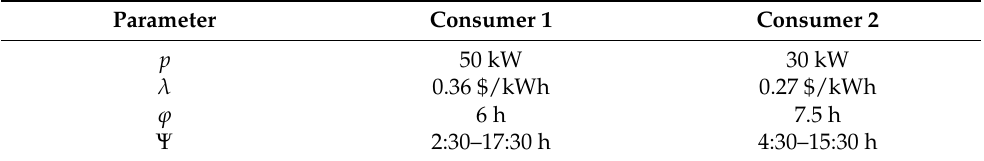
Table 3. Data of shiftable consumers.